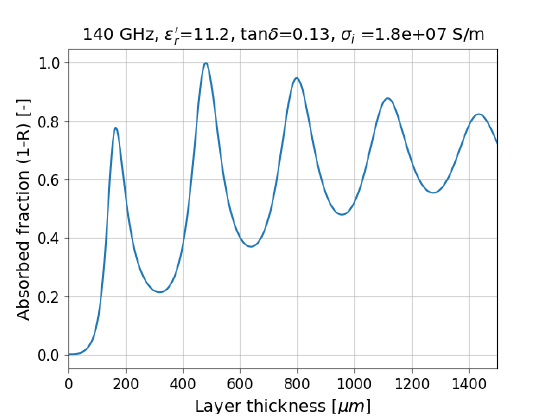
Figure 7. Modelled absorbed fraction (1-R) in coating fitted to experiment data. The maxima and minima are caused by mul- tiple internal reflections. At larger thickness these fade and the absorption converges to 1- R i , with R i the initial reflected frac- tion o ff the boundary. The model shows even larger absorption at next two maxima. These are not experimentally verified but re- sult from larger bulk absorption (longer optical path) coinciding with maxima due to multiple internal reflections.